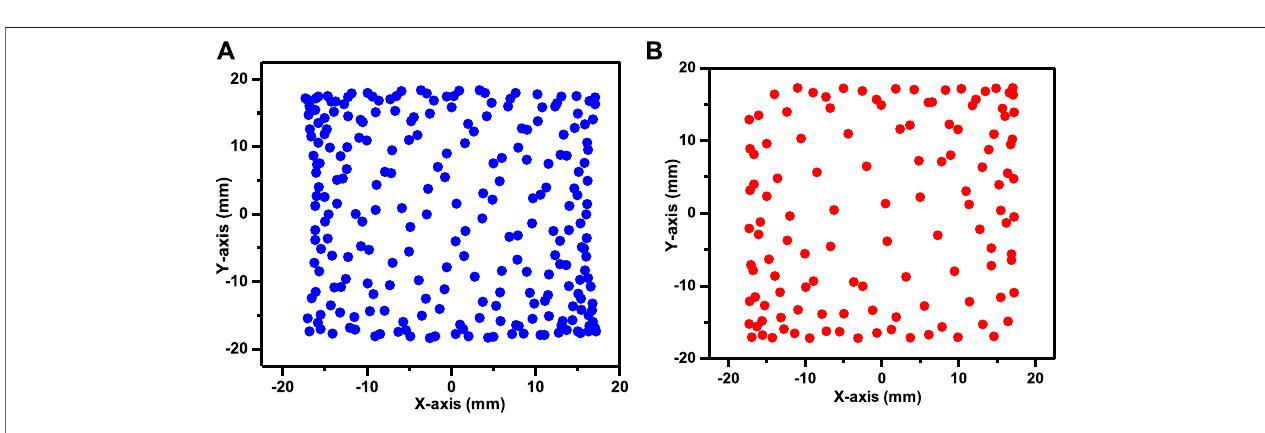
FIGURE8|(A,B) ThespotpatternsofthreedifferentMPCs( C bluedot, C reddot)onsphericalmirrorM 1 stimulatedbyopticalsoftwareandmodi fi edABCDmatrix model, respectively. The optical parameters of spot patterns are identical to that in Figure 5 .